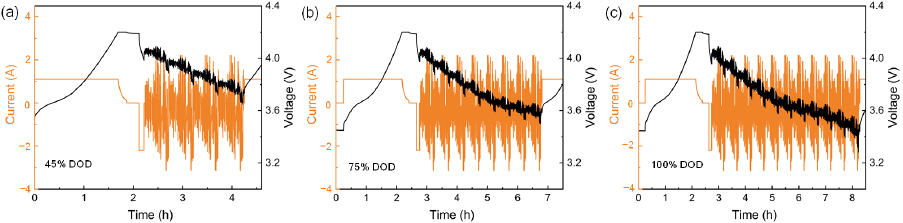
Figure 2. Battery testing using CC-CV charging and the WLTP driving cycle for discharging to investigate the effect of the cycle depth on battery degradation; ( a ) four WLTP cycles are applied to discharge the battery to 55% SOC; ( b ) eight WLTP cycles are applied to discharge the battery to 25% SOC; ( c ) 11 WLTP cycles are applied to fully discharge the battery.